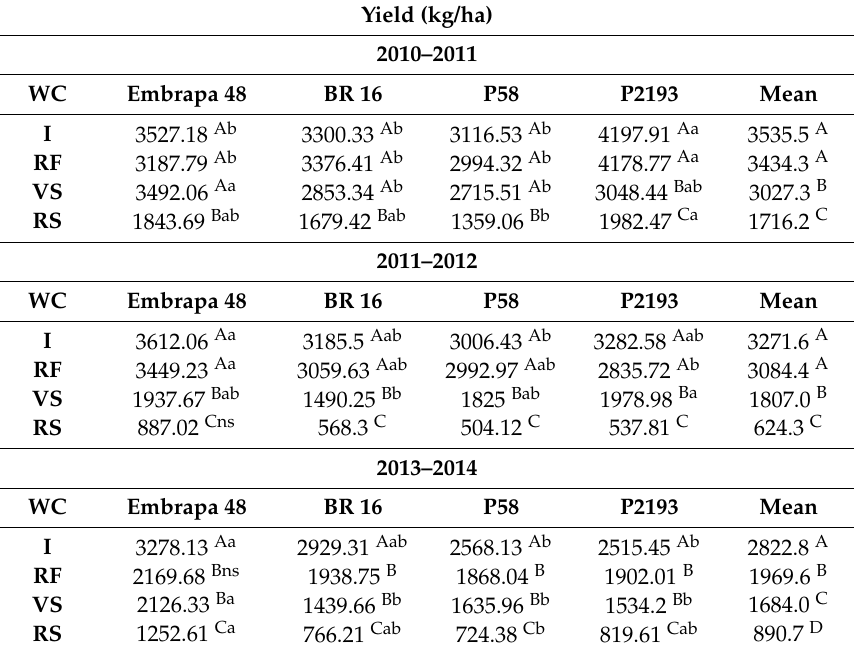
Table 1. Grain yield (kg/ha) in soybean genotypes grown under different water conditions (WC), during three crop seasons in Londrina, Paran á (PR),